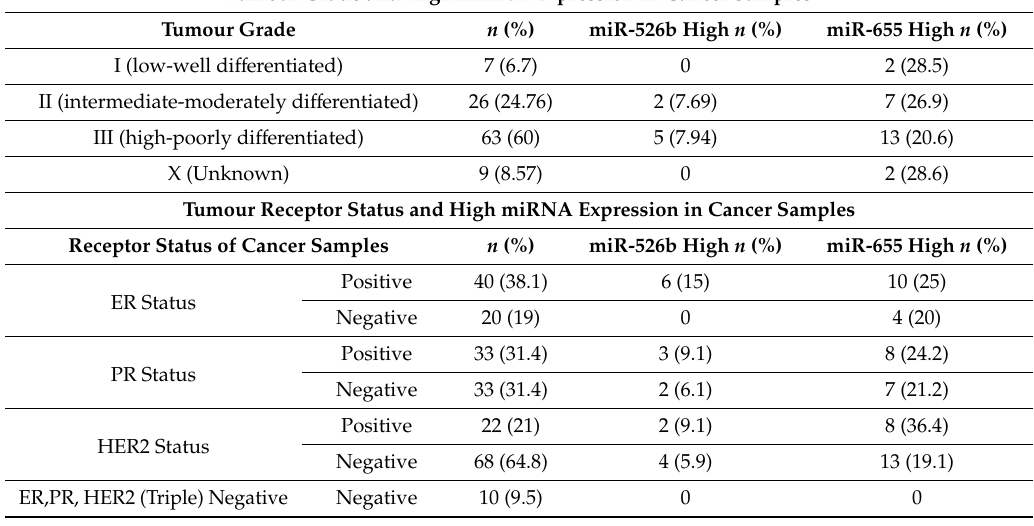
Table 2. Percentage of samples that show higher expression of the two miRNAs (negative delta Ct values) in various stages of tumour and hormonal receptors status. We conducted a Z score analysis by comparing proportions. The analysis shows the proportion of miR526b high expression samples were more in tumor grade II and III; however, this was not significant. For miR655, there was no di ff erence in the distribution of high expression across tumor grades recorded. A higher proportion of samples showing high miR526b and miR655 expression can be seen in ER positive samples; however, the di ff erence is not statistically significant, although larger sample size may increase significance. Other receptor status also shows no significant di ff erence between presence or absence of individual receptor. Tumour Grade and High miRNA Expression in Cancer Samples Tumour Grade n (%) miR-526b High n (%) miR-655 High n